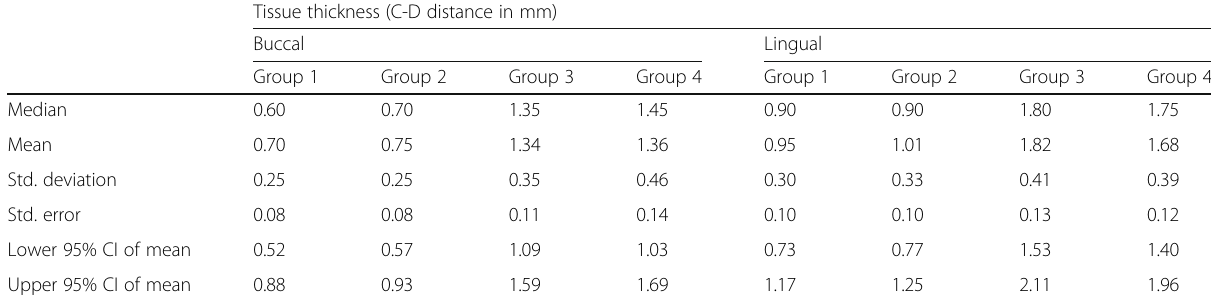
Table 2 Mean, median, standard deviation, and standard error for each group evaluated for lingual as well as buccal sites of the tissue thickness (in mm) for all groups